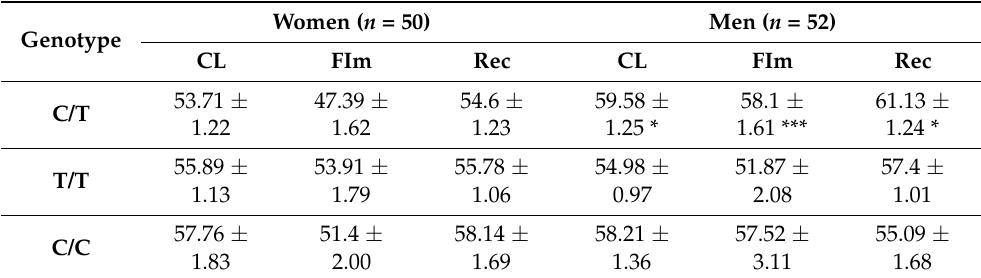
Table 7. Difference in diastolic index (DSI, %) between men and women with matched ADRA1A p.Arg347Cys (rs1048101)